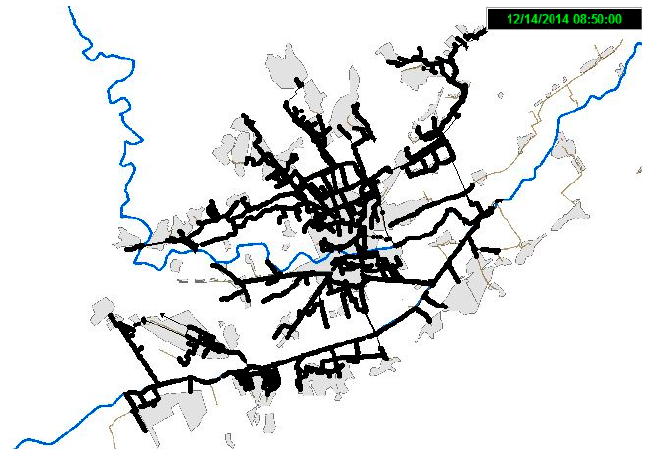
Figure 3. View of the hydraulic model of Murcia in USEPA Storm Water Management Model (SWMM). Table 3. Description of the hydraulic model of Murcia.